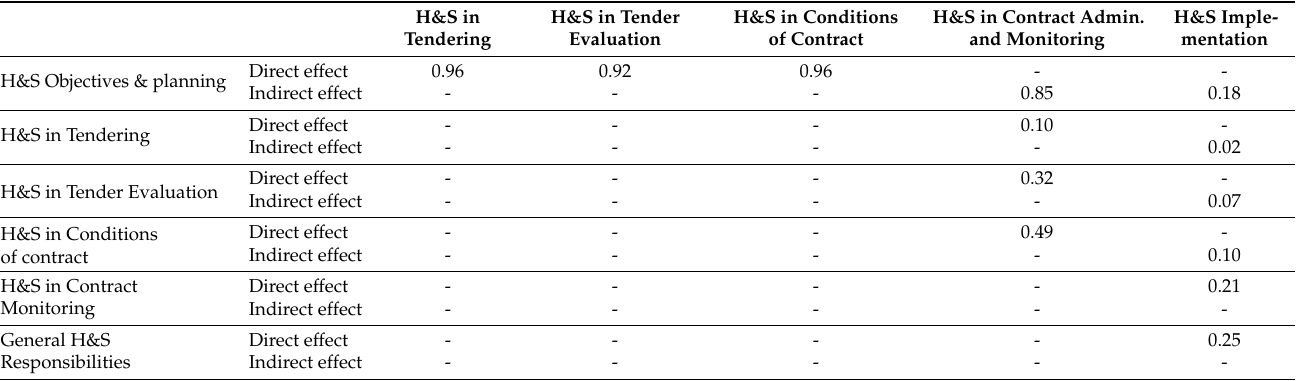
Table 7. Direct and indirect effects of